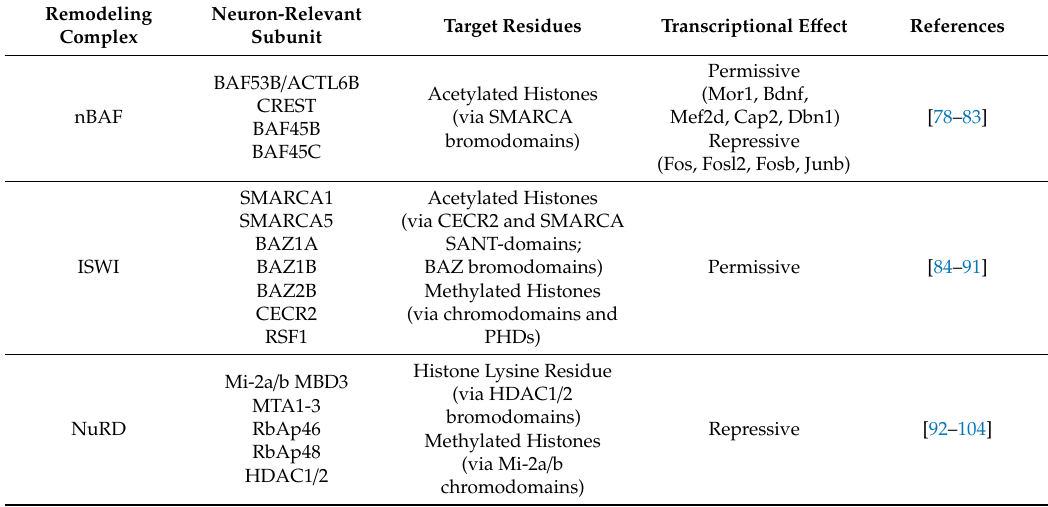
Table 2. Chromatin remodeling complexes regulate long-term